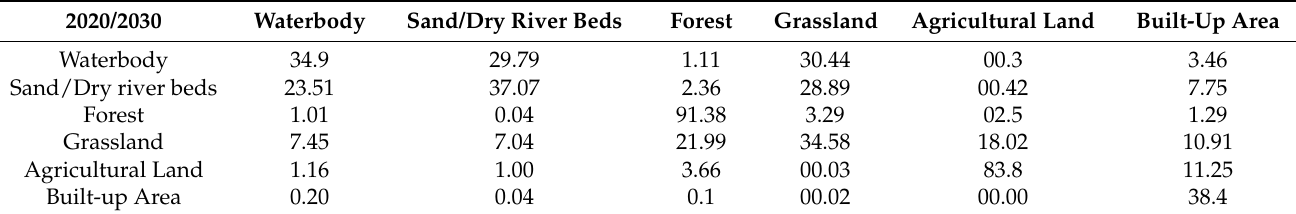
Table 6. Probability of LULC changes in 2030 by percentage.